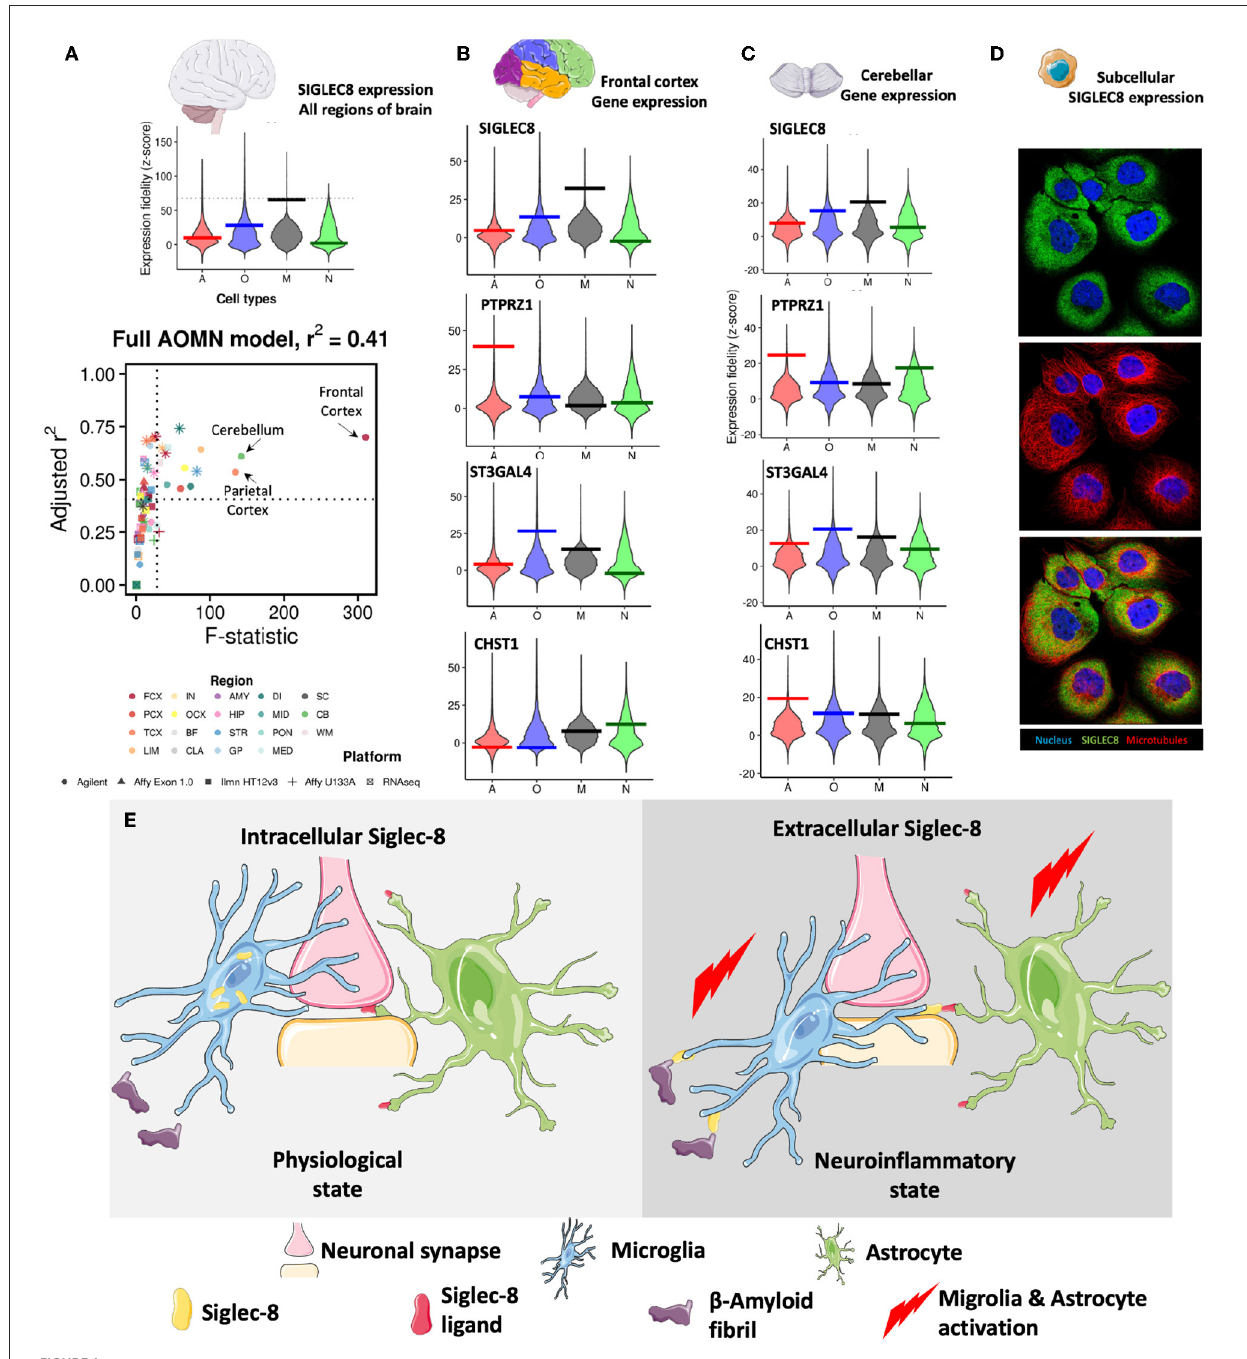
FIGURE1 (A) SIGLEC8 is expressed by microglia and its expression is highest in the frontal cortex, parietal cortex, and the cerebellum. Genome-wide distributions of expression fidelity for astrocytes (A) , oligodendrocytes (O), microglia (M), and neurons (N) over all analyzed samples are shown. The horizontal line denotes the expression fidelity of the query gene for each cell type. The dashed horizontal line denotes the threshold above which all fidelity scores had Confidence = 100. Lower panel shows modeling results for expression levels of the SIGLEC8 as a function of variation in the inferred abundance of individual cell types. Simple linear regression is used to predict gene expression levels as a function of estimated neuron, astrocyte, oligodendrocyte, or microglia abundance in all human CNS regional datasets containing the query gene. Adjusted R 2 values and t-values are shown for each cell type (labeled by color, with shapes denoting technology platforms). (B) Expression data of SIGLEC8, PTPRZ1, ST3GAL4, and CHST1 in the frontal cortex. (C) Expression data of SIGLEC8, PTPRZ1, ST3GAL4, and CHST1 in the cerebellum [data for (A–C) obtained from (http:// oldhamlab.ctec.ucsf.edu)] (D) SIGLEC8 is localized to the subcellular compartment. Immunofluorescence images of the A-431 cell line stained with the HPA012556 SIGLEC8 antibody ( https://www.proteinatlas.org/ENSG00000105366-SIGLEC8/subcellular#img, Human Protein Atlas https://www. proteinatlas.org) (E) Hypothetical effects of intracellular and extracellular expression of SIGLEC-8 Region FCX, frontal cortex; PCX, parietal cortex; TCX, temporal cortex; LIM, limbic cortex; IN, insular cortex; OCX, occipital cortex; BF, basal forebrain; CLA, claustrum; AMY, amygdala;